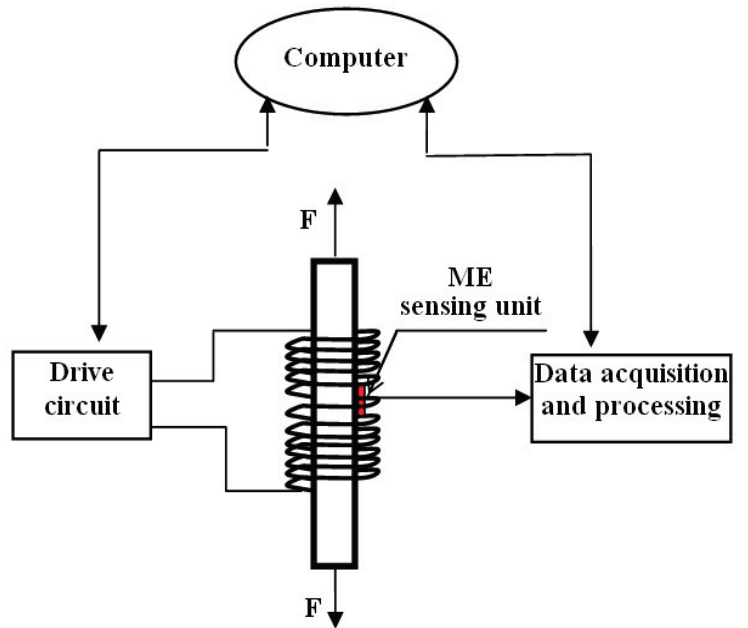
Figure 1. Schematic diagram of the proposed elasto-magneto-electric (EME) sensory